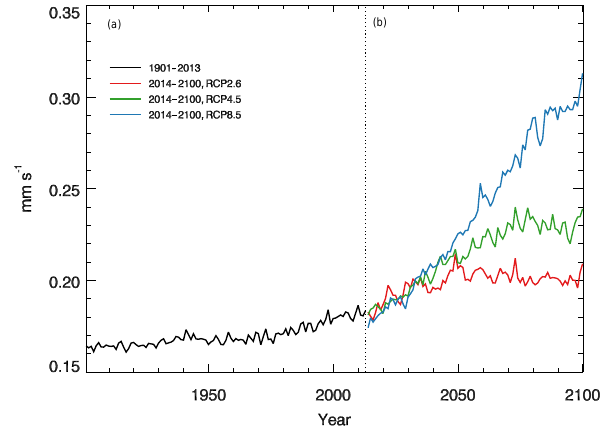
Figure 9. Global mean annual time series of CO deposition velocity (mms − 1 ) using constant in time and spatially distributed CO con- centration data during 1901–2013 (a) and under the future climate scenarios RCP2.6, RCP4.5 and RCP8.5 during 2014–2100 (b)